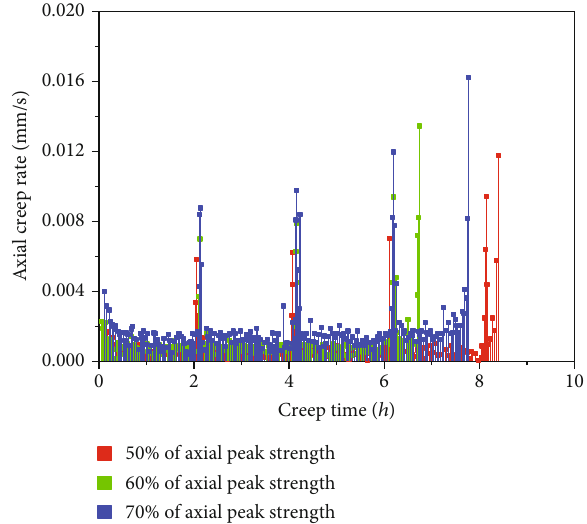
Figure 6: The relationship between axial creep rate and creep